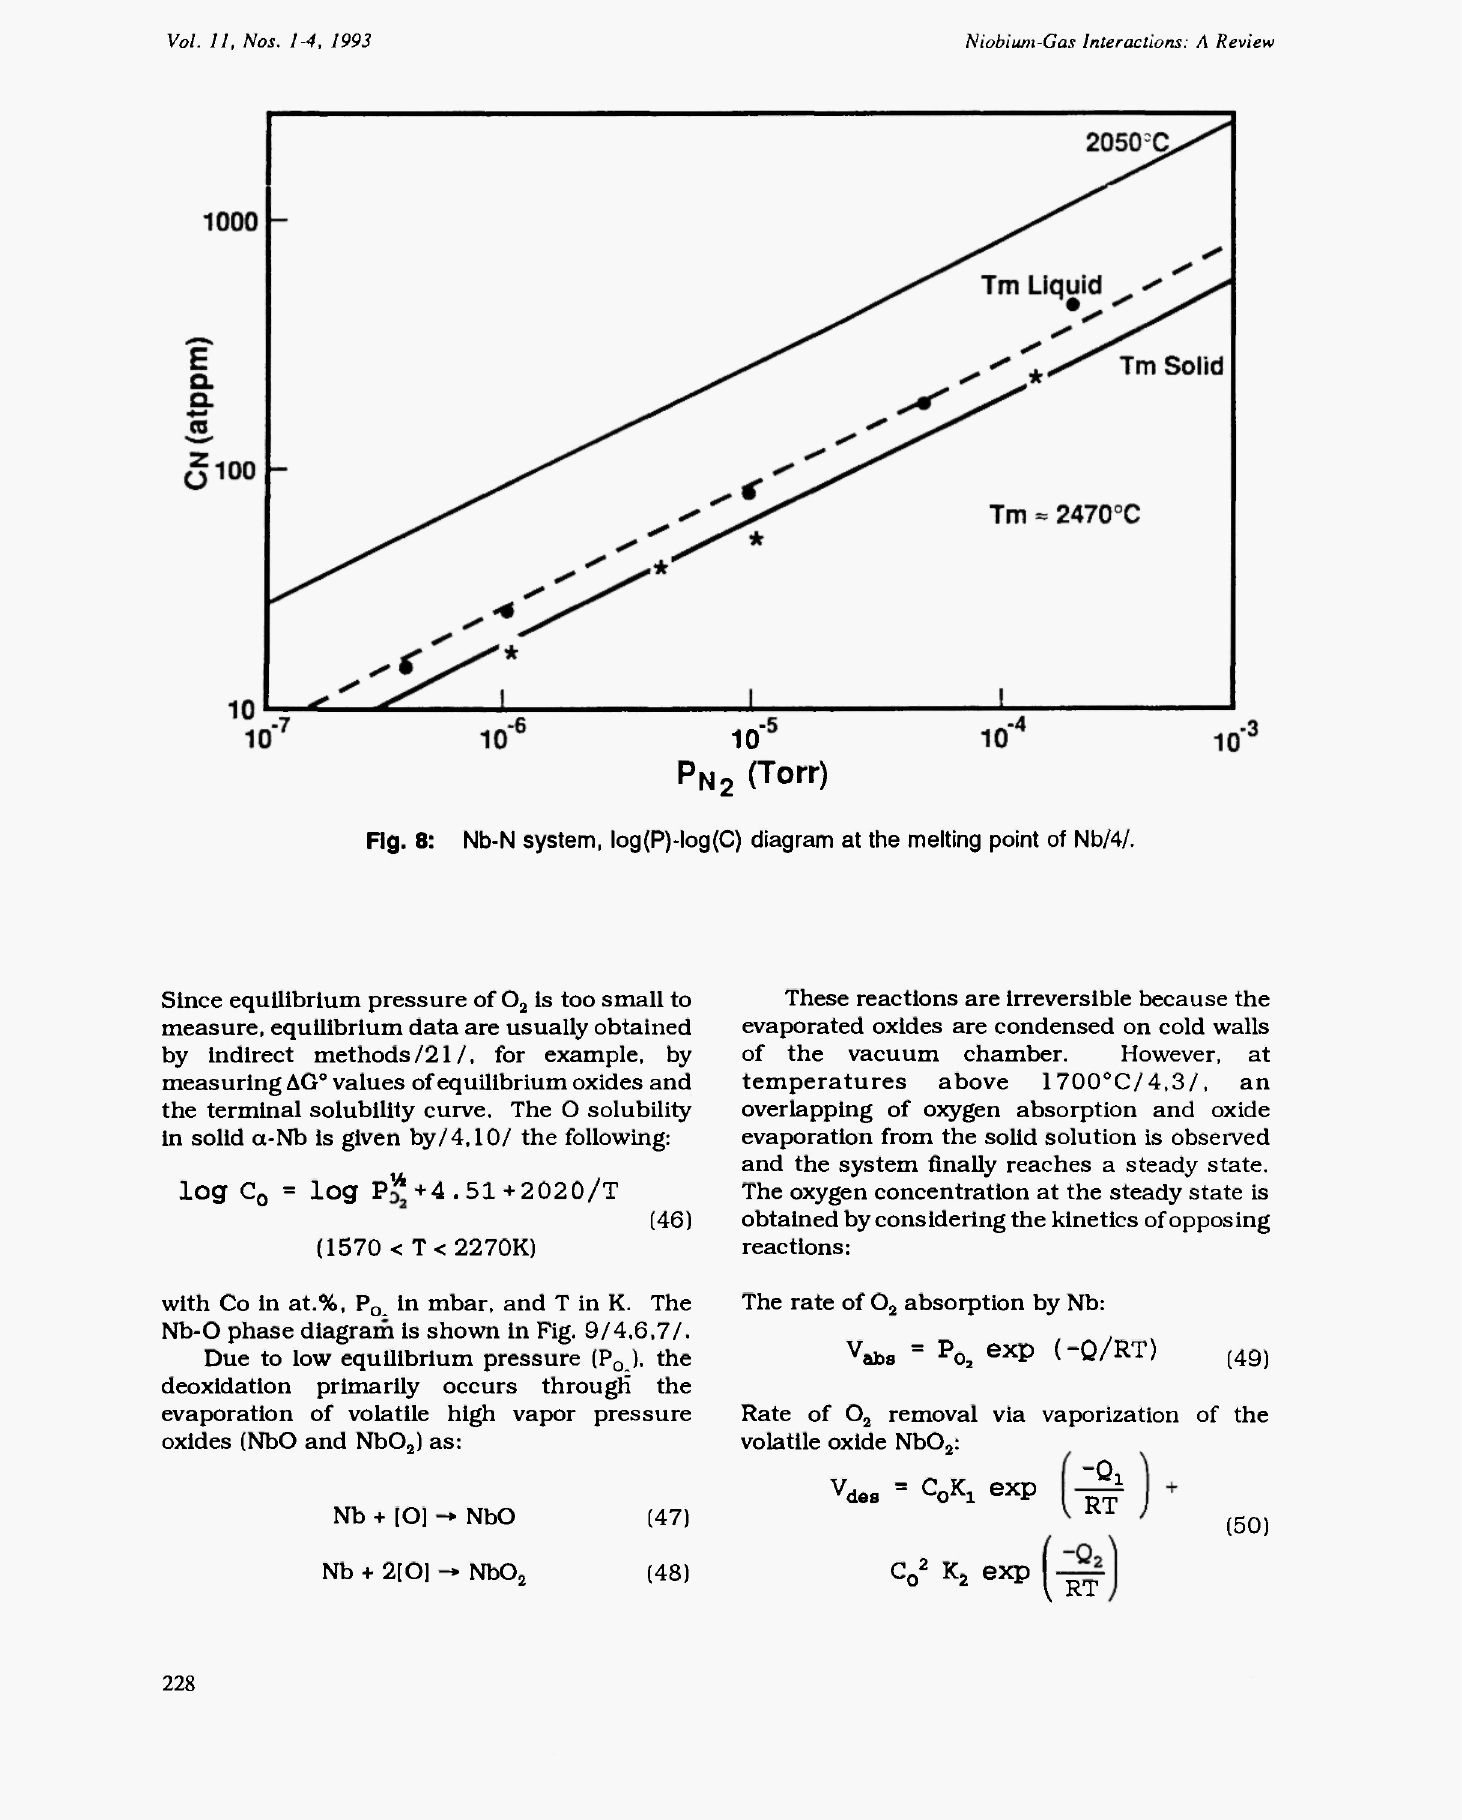
These reactions are irreversible because the evaporated oxides are condensed on cold walls of the vacuum chamber. However, at temperatures above 1700°C/4,3/, an overlapping of oxygen absorption and oxide evaporation from the solid solution is observed and the system finally reaches a steady state. The oxygen concentration at the steady state is obtained by considering the kinetics of opposing